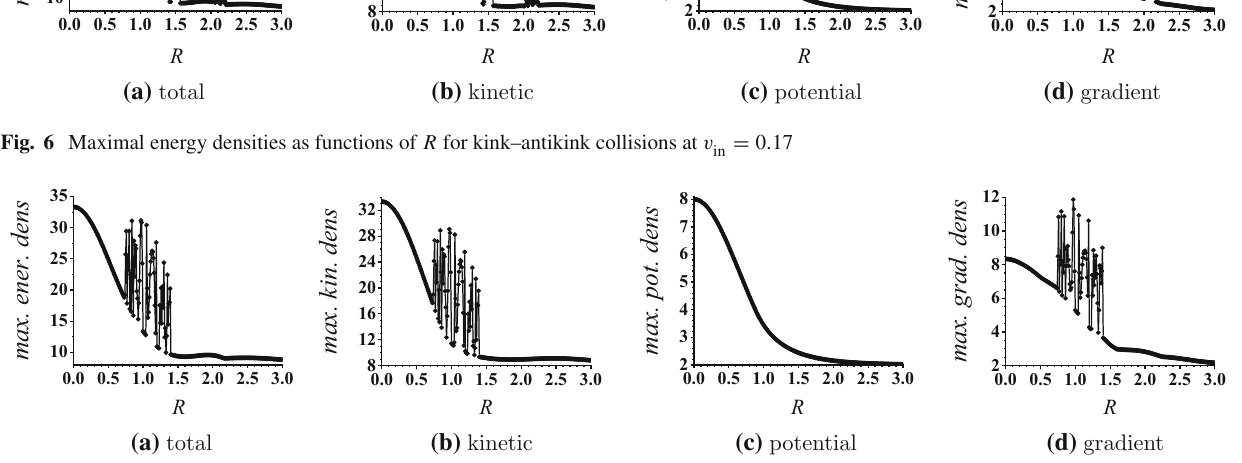
Fig. 7 Maximal energy densities as functions of R for kink–antikink collisions at v